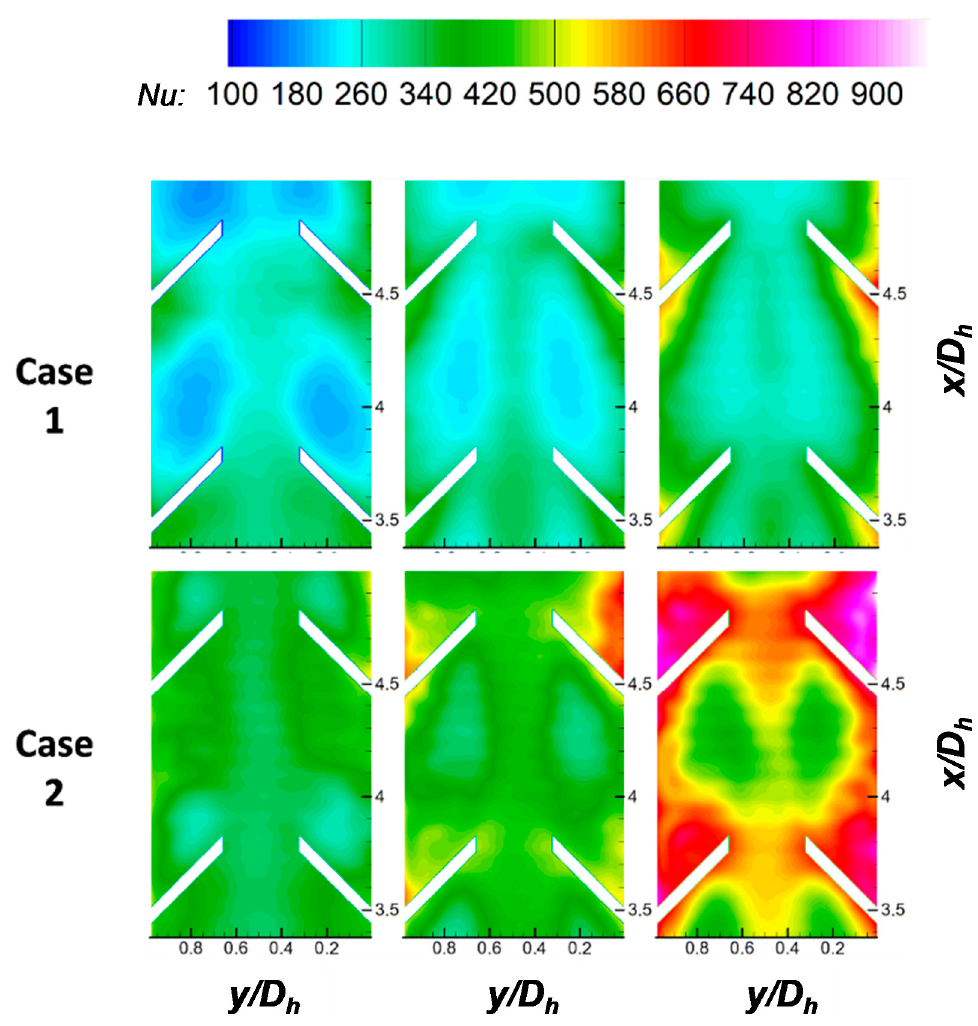
Figure 9. Nusselt number distribution of the mist flow on the broken V-shaped ribbed surface.